Question: Generate an informative caption for the figure above.
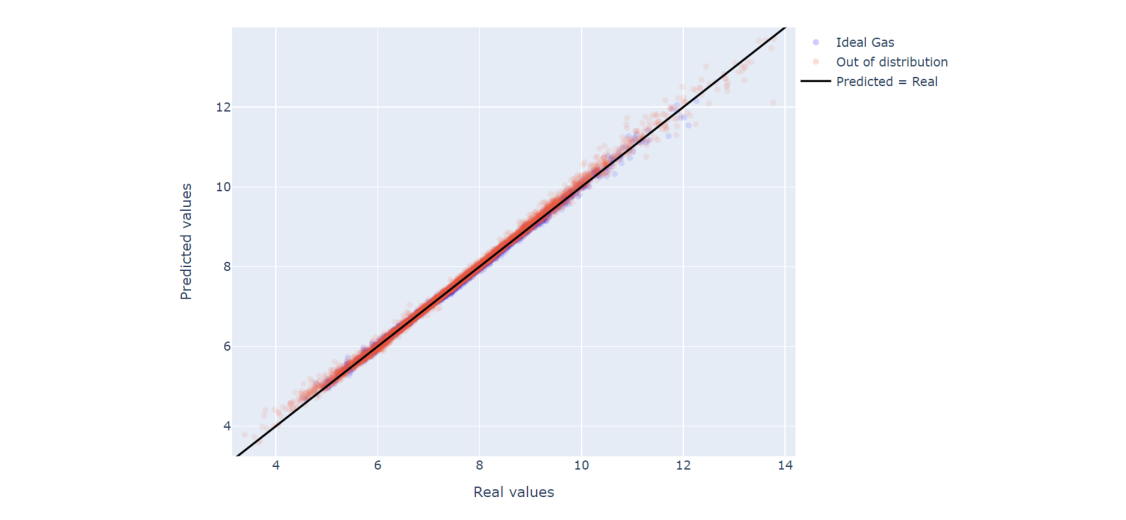
Answer: Predicted vs. Real Pressure, Experiment 2